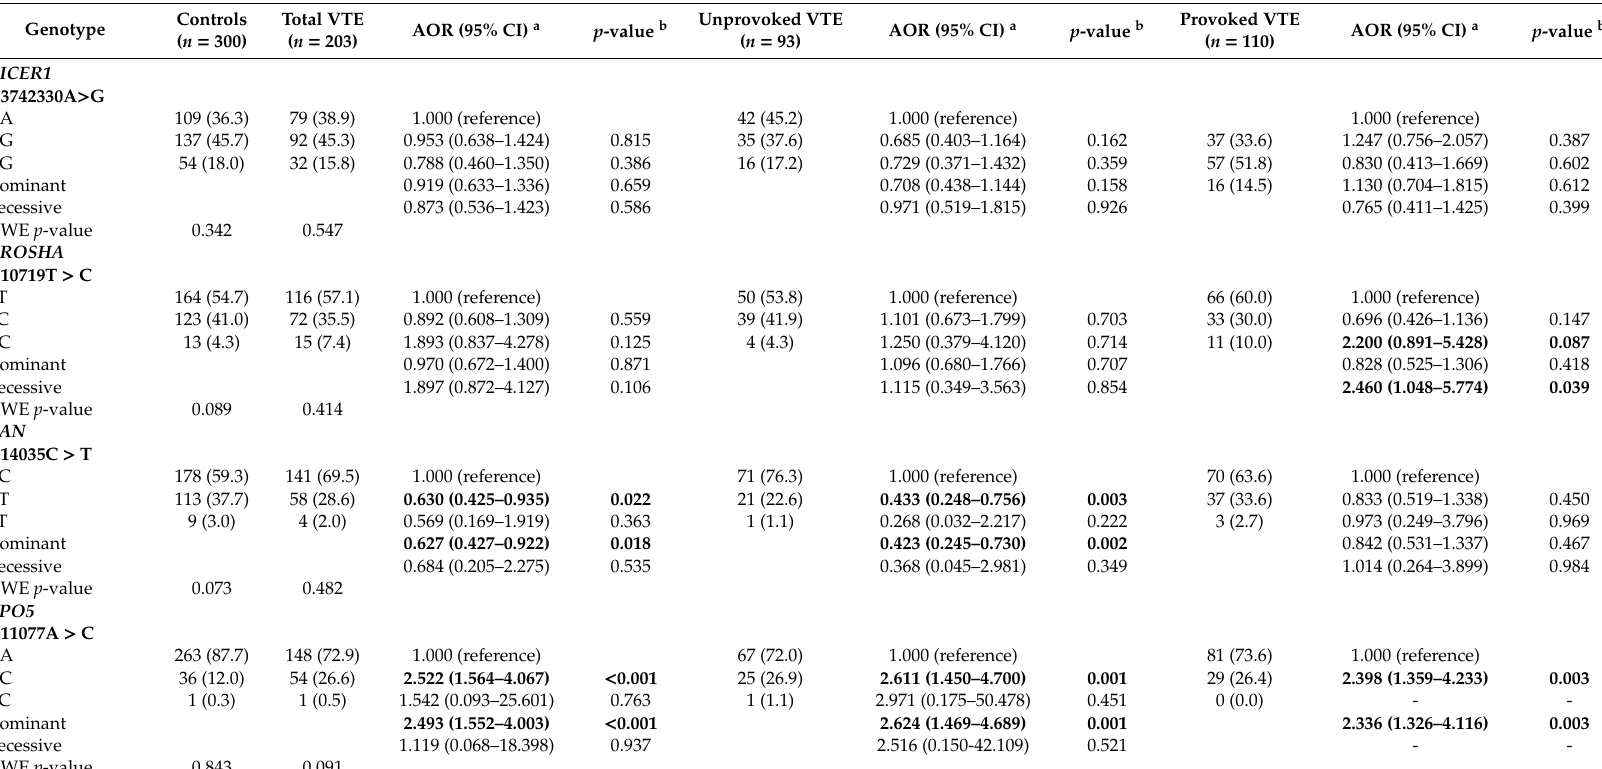
Table 2. Genotype frequencies of DICER1 , DROSHA , RAN , and XPO5 polymorphisms in VTE patients and